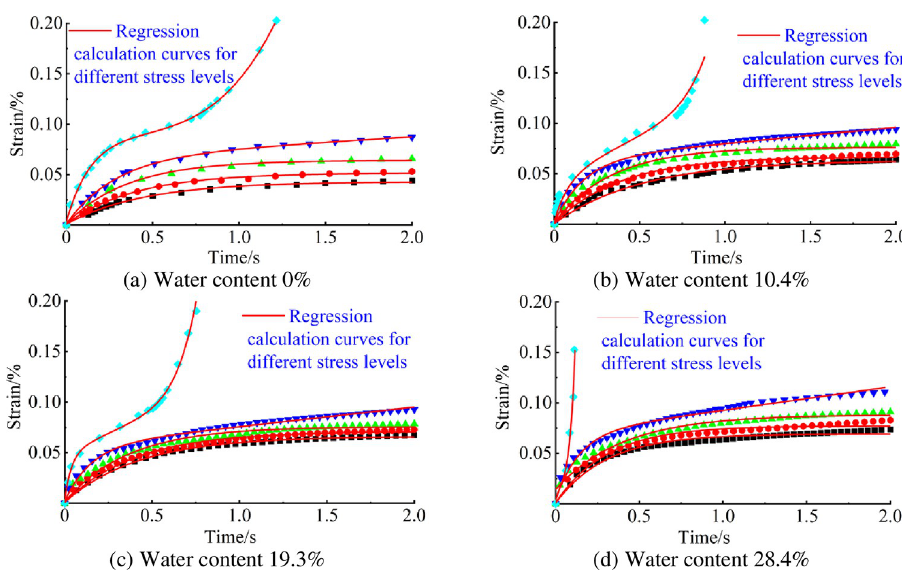
Fig 9. Regression effects of the age-damaged creep model considering the water content. (a) Water content 0%, (b) Water content 10.4%, (c) Water content 19.3%, (d) Water content 28.4%.